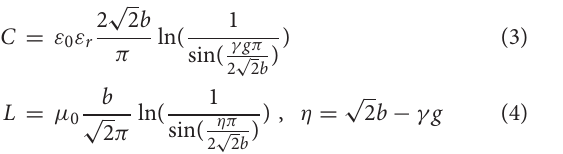
Frontiers in Physics |